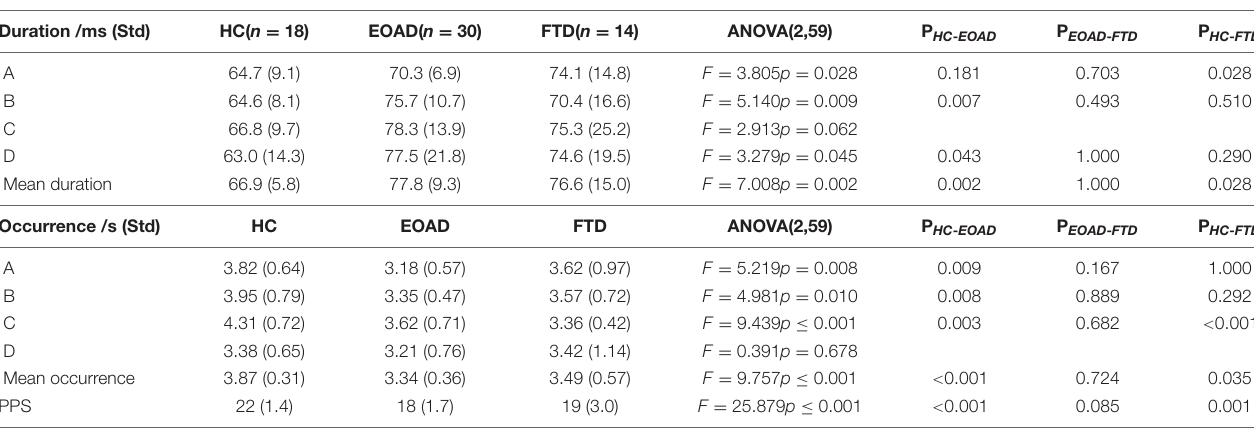
FIGURE 1 | Microstate class topographies. The letters of (A–D) on the top represent the four microstate classes, respectively. Group comparisons used by TANOVA. Significant p -values after Bonferroni correction are illustrated. FTD had different microstate (A) map from HC and EOAD. Microstate (B,C) map was different in EOAD, compared to HC. No group difference in microstate (D) was observed. FTD, frontotemporal dementia; EOAD, early onset Alzheimer’s disease; HC, healthy controls. TABLE 3 | EEG microstate data in dementia and control